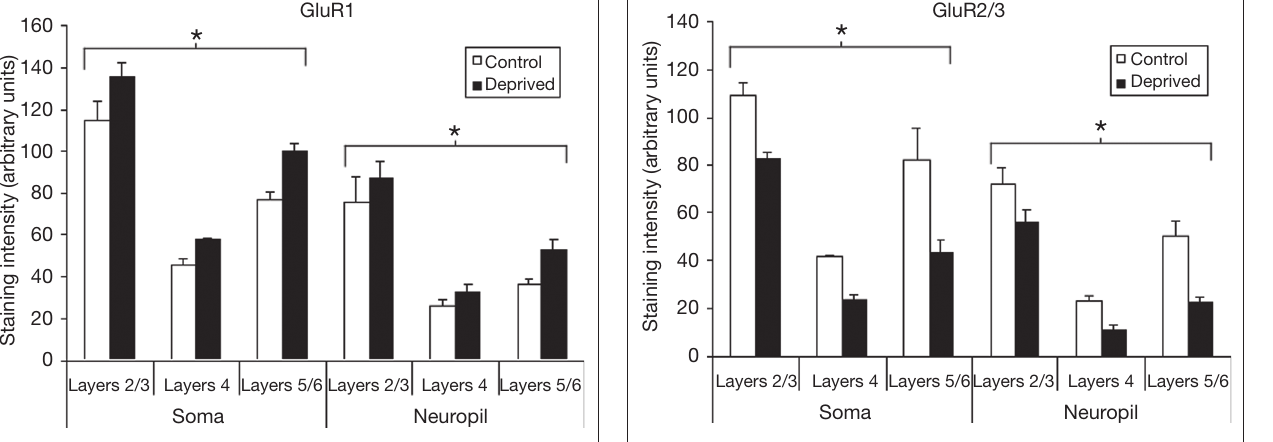
FIGURE 3 | Comparison of average staining intensities for GluR1 in deprived and control hemispheres. Conventions are the same as in Figure 2 . GluR1 staining intensities are higher in the deprived hemisphere in all layers for both cell body and neuropil measurements (* p < 0.001).